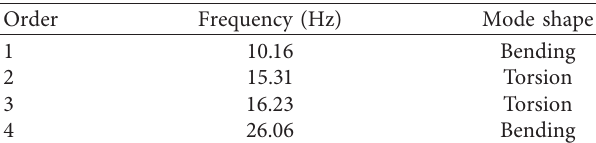
Table 2: Test results of the first four-order natural frequencies of the rotary